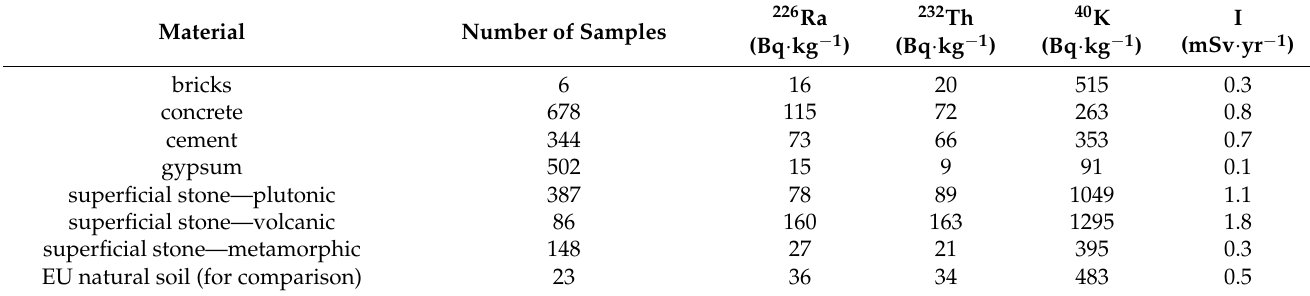
Table 1. Average radioactivity concentration in building materials for Poland [19]. EU, European